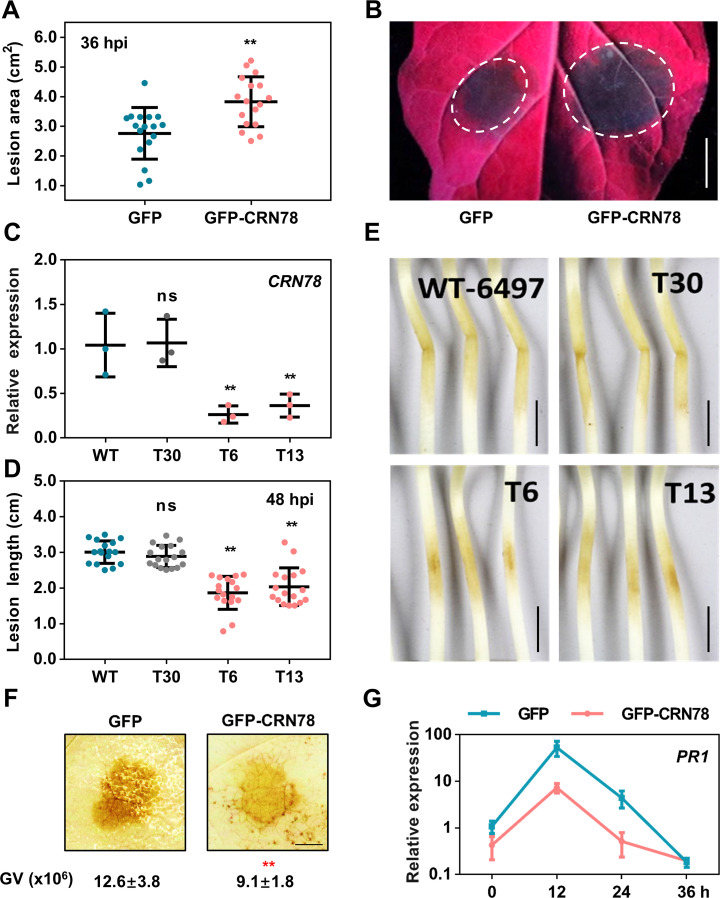
P. sojae CRN78 promotes oomycete pathogen infection and inhibits plant immunity.(A and B) Enhanced P. capsici infection in N. benthamiana leaves expressing CRN78. The infiltrated area expressing GFP or GFP-CRN78 was infected with P. capsici. Lesion areas at 36 hpi (A) were calculated from three independent biological replicates using at least five leaves in each replicate (mean ± SD; n = 17; **, P < 0.01, Student’s t-test). The typical photographs (B) were taken at 36 hpi under UV light. (C) Relative transcript levels of CRN78 in different transgenic P. sojae lines. WT: wild type P6497; T6 and T13: CRN78-silenced transformants; T30; a non-silenced transformant with same construct. The transcript levels were analyzed by qRT-PCR and normalized to that in the WT using the actin gene as an internal reference (mean ± SD; n = 3; **, P < 0.01 compared with the WT; Student’s t-test). (D and E) Reduced lengths of lesions on etiolated soybean hypocotyls inoculated with the CRN78-silenced P. sojae. Soybean cv. Williams was inoculated with ~100 zoospores of the P. sojae lines indicated. Lesion lengths (D) were analyzed at 48 hpi (mean ± SD; n > 15, **, P < 0.01 compared with WT; Student’s t-test). The typical phenotypes of lesions have been shown. Bar: 1 cm. (F) ROS accumulation in N. benthamiana.
P. capsici was inoculated at 36 h post infiltration. DAB staining was conducted at 12 hpi. Integral grey value of DAB stained region was shown below (mean ± SD; n = 6, P < 0.01; Student’s t-test). (G) Relative transcript levels of NbPR1. The transcript levels of NbPR1 in N. benthamiana leaves expressing GFP or CRN78 were analyzed by qRT-PCR with actin as the internal reference (mean ± SD; n = 3).